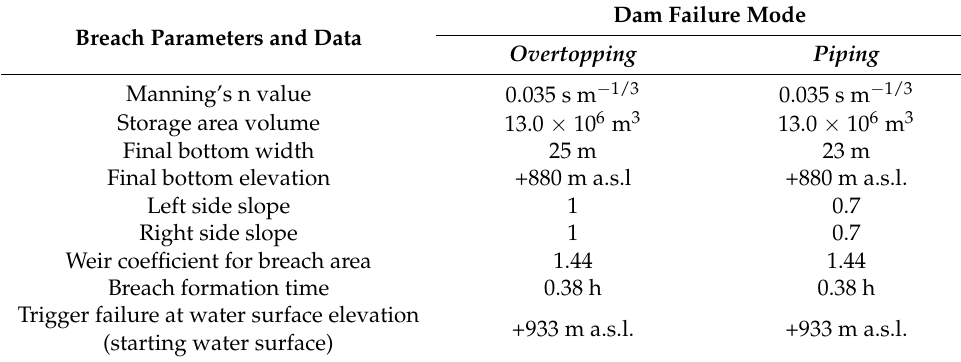
Table 4. Breach parameters for the dam failure